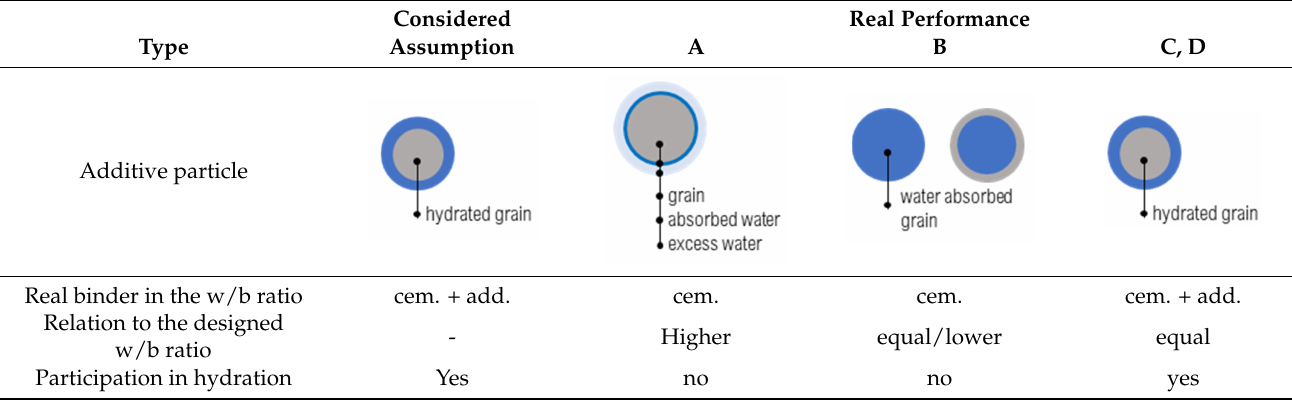
Table 7. Assumptions for mineral additive